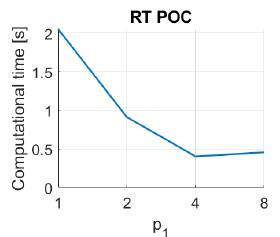
Figure 18. RT–F image retrieval problem. Computational time.